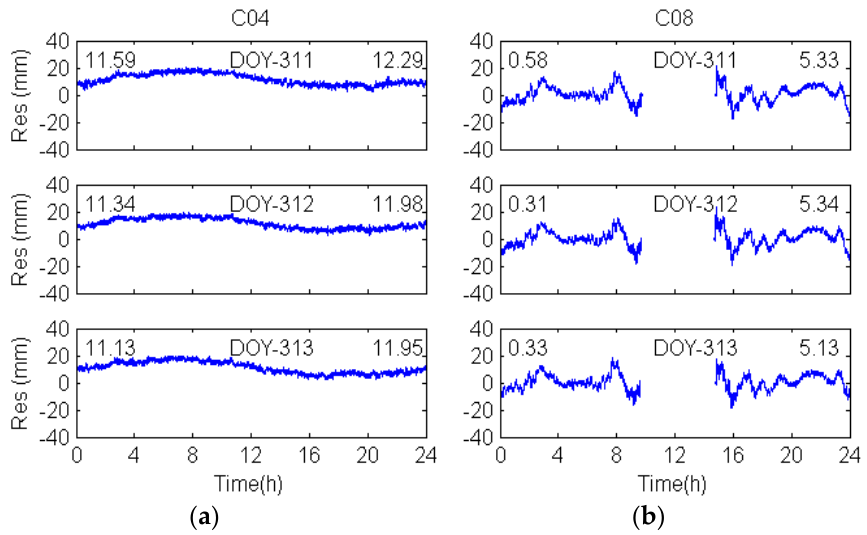
Figure 5. Denoised DD residuals of GEO ( a ) and IGSO ( b ) for three consecutive days. Numbers (unit: mm) in the top left and right corners represent the mean and RMS value of the DD residuals, respectively.